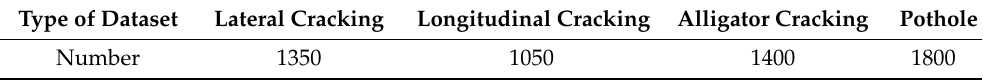
Figure 5. Partial image of four typical defect types in PCD1. ( a ) lateral cracking, ( b ) longitudinal cracking, ( c ) alligator cracking, and ( d ) pothole. Table 1. Details of defect distribution in the PCD1